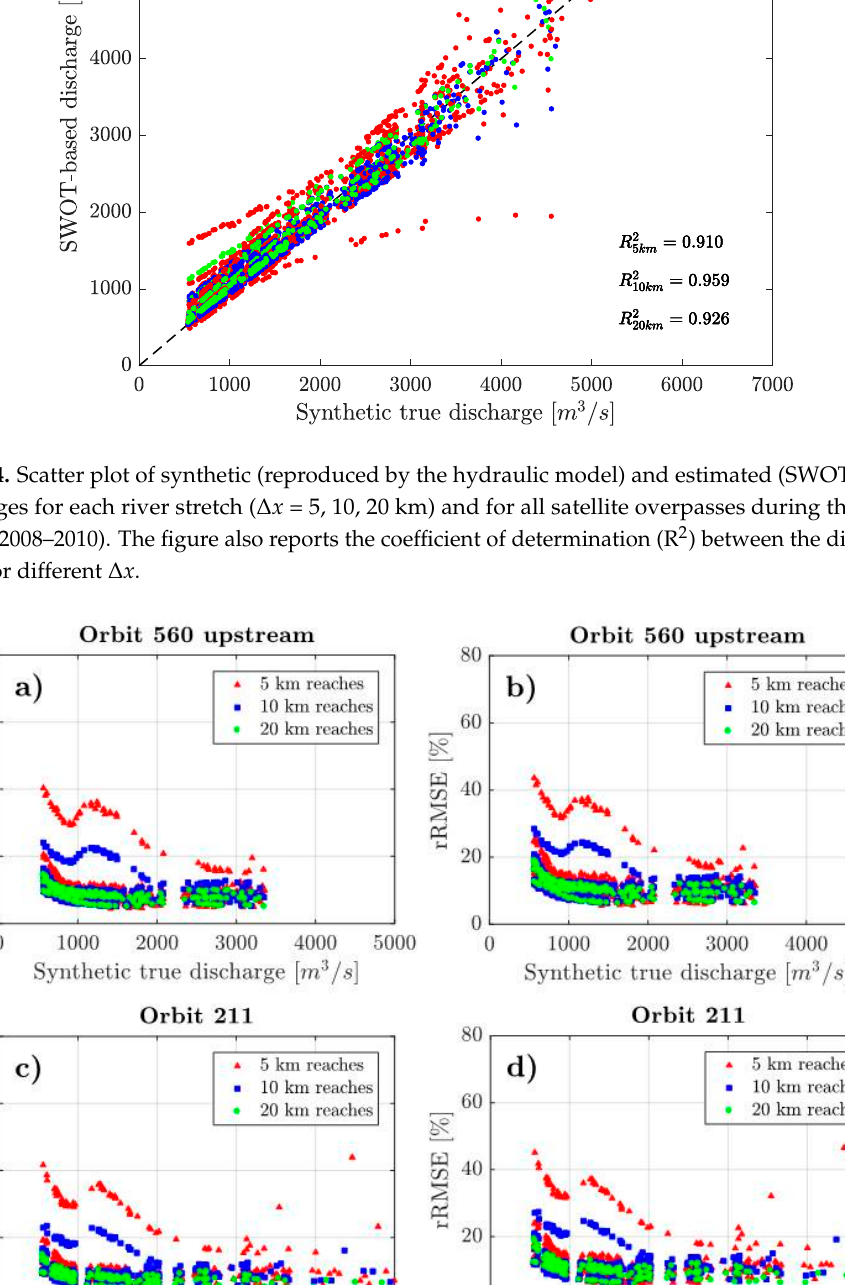
Figure 5. Example of rRMSE and rMAE for two swaths observed by SWOT: orbit 560 (left swath) and orbit 211 (right swath; see also Figure 2).